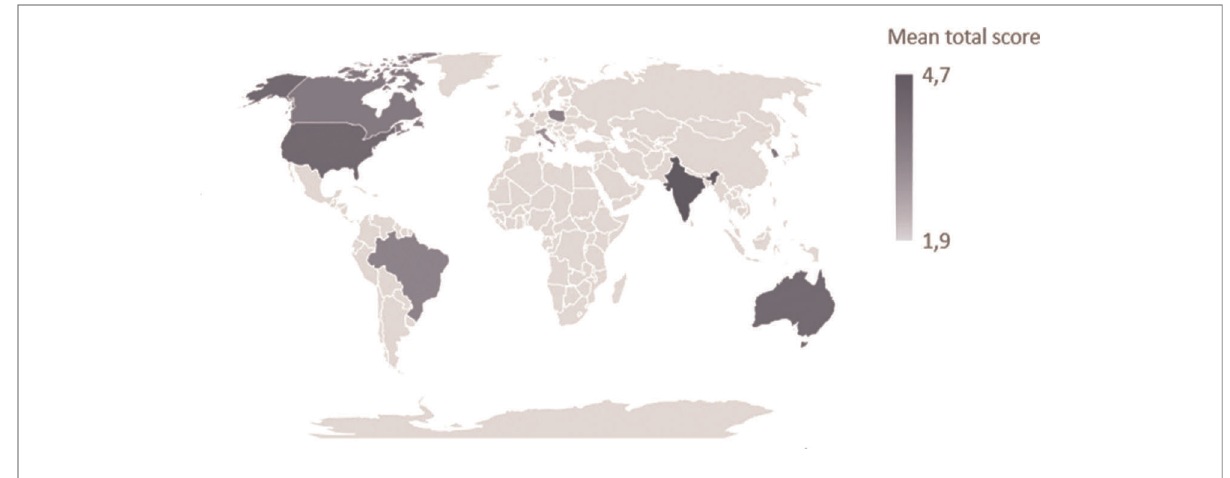
fi lled out the “ priorities identi fi cation ” section of the survey: three from Europe, three from Asia, two from North America, one from South America and one from Oceania ( Figure 1 ).